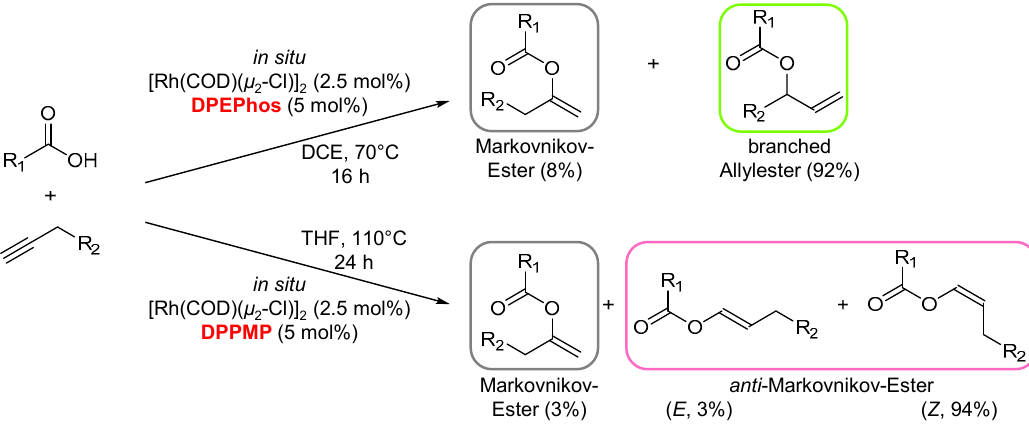
Scheme 1. In situ generation of rhodium / diphosphine complexes—known range of species which can be formed during the in situ reaction of rhodium diolefin precursors with diphosphine ligands.